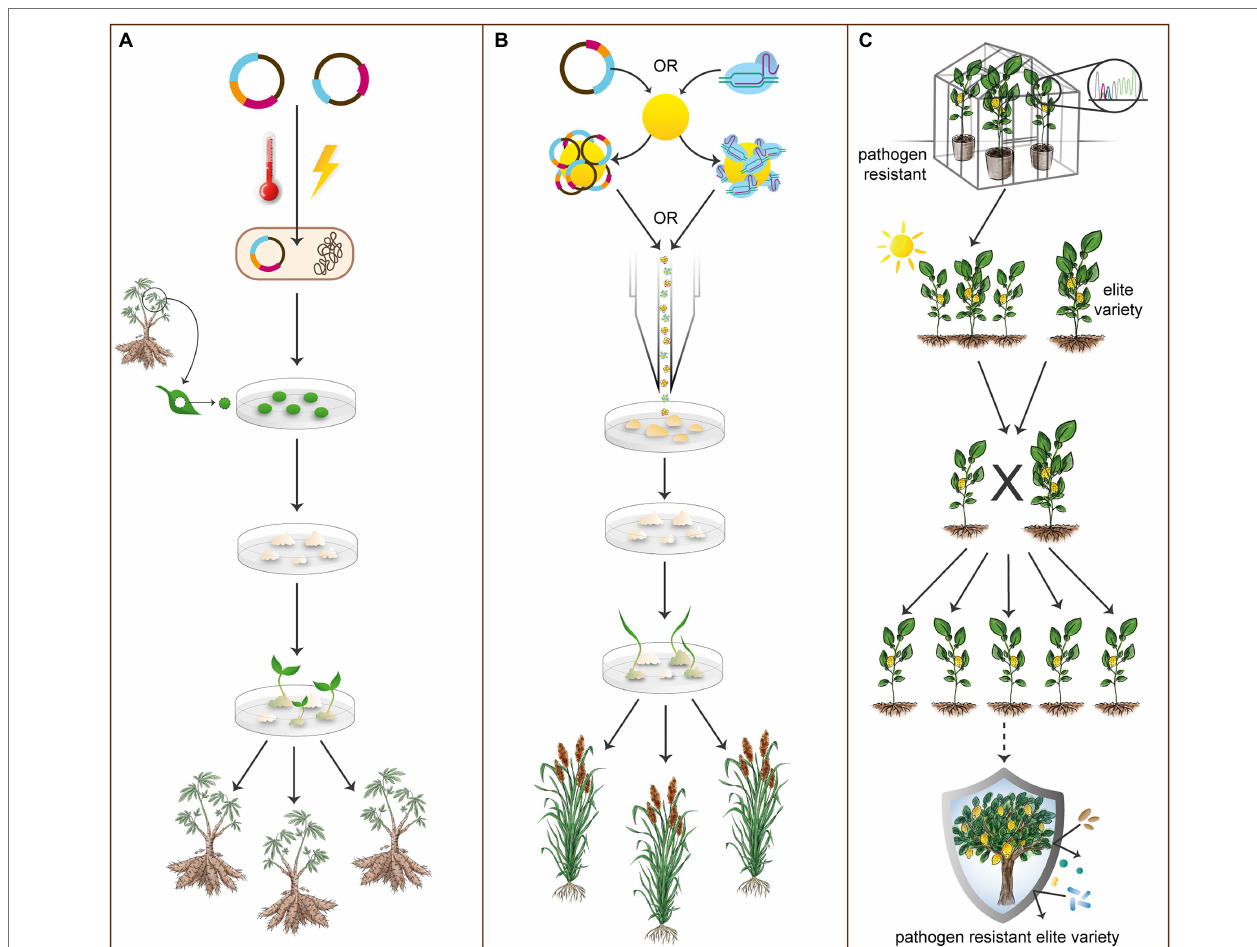
FIGURE 3 | Transformation, regeneration, and breeding methods in orphan crops. (A) An overview of Agrobacterium -mediated transformation. Constructs are first transformed into agrobacteria. Transformed agrobacteria are then co-cultivated with callus tissue from plant material derived from the target organism. Various types of plant material can be utilized, including leaf explants (shown here). Following transformation and callus induction, shoot and root tissue is then regenerated. As shown, most root/tuber crops are predominantly transformed by Agrobacterium -mediated methods (see Supplementary Table 1 ). (B) An overview of biolistic bombardment. Constructs or RNPs are loaded into gold particles and a biolistic particle-based delivery system is utilized to bombard the plant material. Plant material is then regenerated after callus tissue induction. This method of transformation is particularly employed for species considered recalcitrant to Agrobacterium -mediated methods. As shown, cereal crops, such as sorghum, may be transformed by biolistic bombardment, though this method is less prevalent than Agrobacterium -mediated transformation in orphan crops (see Supplementary Table 1 ). (C) A simplified representation of breeding methods utilized to allow the introgression of gene edited alleles from lab varieties into grower-preferred varieties. Transgene-free gene edited plants that exhibit a desired trait (disease resistance, shown here) are crossed with elite, grower-preferred varieties in marker-assisted breeding to produce an elite variety with the desired gene edited allele. In this manner, gene edited alleles may be introgressed into elite lines considered recalcitrant to conventional transformation